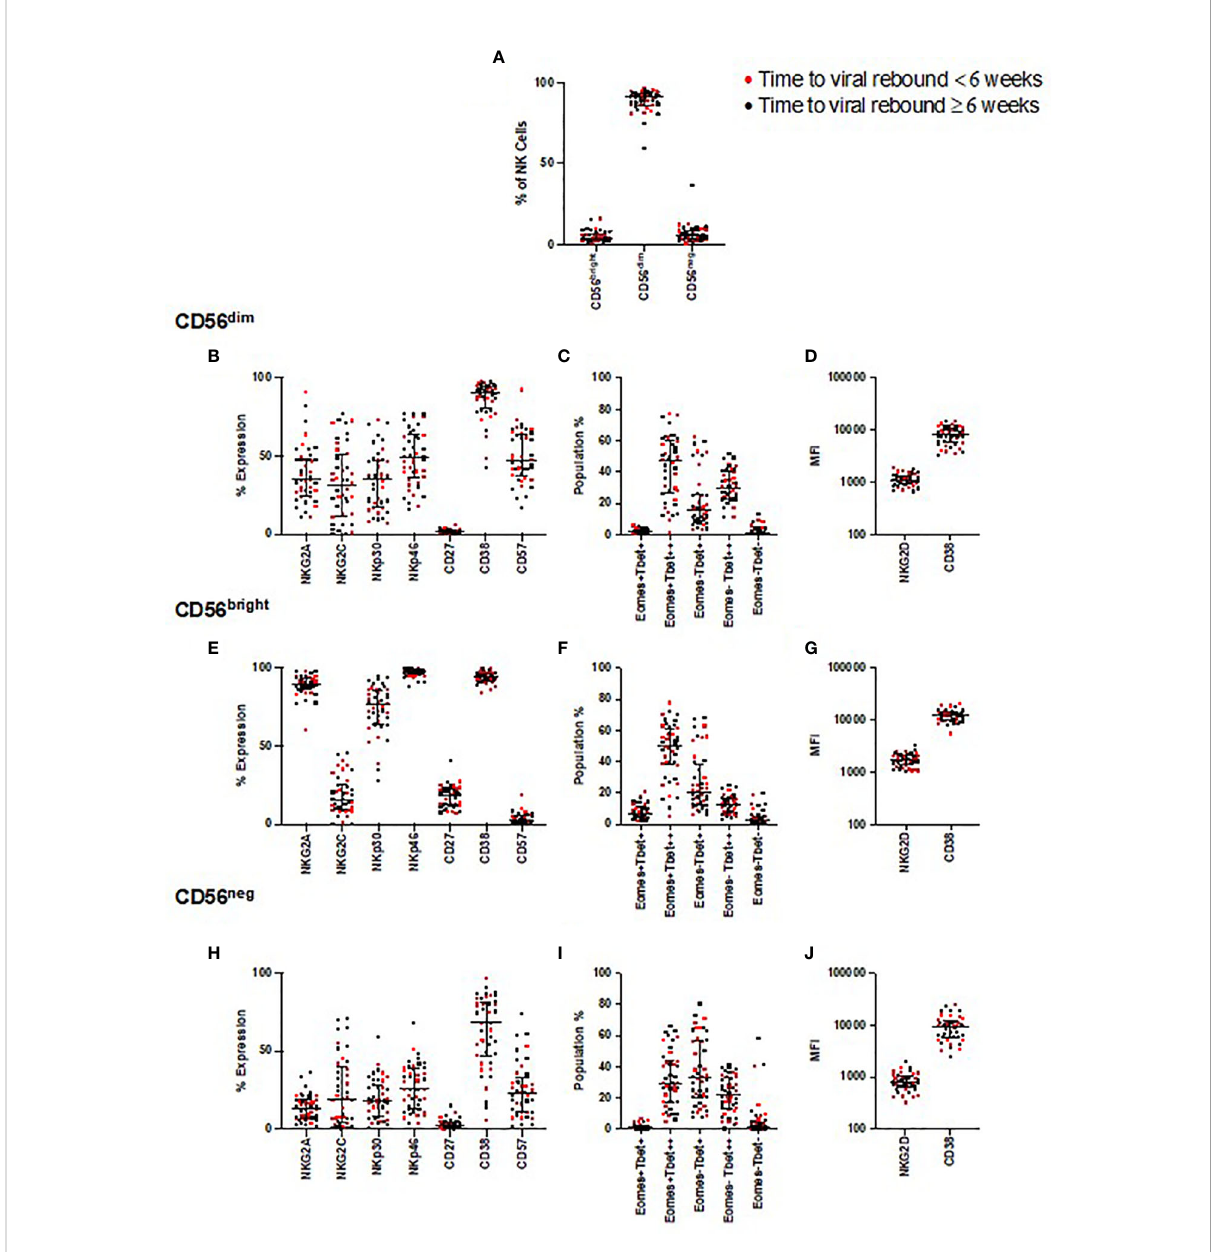
FIGURE 2 NK cell phenotyping and time to viral rebound. PBMC from SPARTAC patients (n = 44) were stained and divided into CD56 dim , CD56 bright , and CD56 neg NK cells (A) . Red circles indicate individuals with time to viral rebound < 6 weeks and black circles indicate individuals with time to viral rebound ≥ 6 weeks. Expression as a percent or median fl uorescent intensity is shown for CD56 dim NK cells (B – D) , CD56 bright (E – G) and CD56 neg NK cells (H – J) . For all graphs, median values with interquartile range are shown. A blue box represents those that were different at baseline but corrected over 2 years of ART, a red box represents those that were different at baseline but which did not correct after two years of